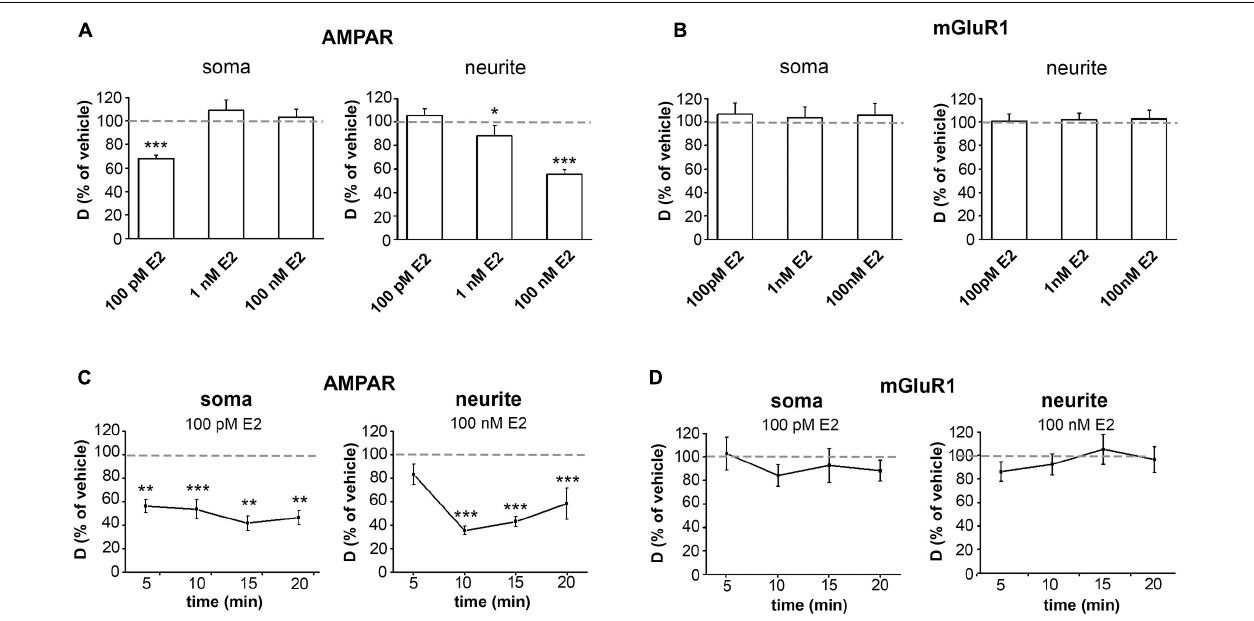
FIGURE 2 | Effect of E2 on the surface movement of GluR2-AMPAR and mGluR1. (A) Effect of different concentrations of E2 on the diffusion coefficient (D, µ m 2 /s) of GluR2-AMPAR (A) and mGluR1 (B) (% of vehicle treatment as the mean ± SEM, n = 425–1145 trajectories per group). (C,D) Line graphs depict changes in D of GluR2-AMPAR (C) and mGluR1 (D) molecules at different time points after the administration of the most effective concentration of E2 (% of vehicle treatment as the mean D ± SEM, n = 117–187 trajectories per time point). * p < 0.05; ** p < 0.01; *** p < 0.001.